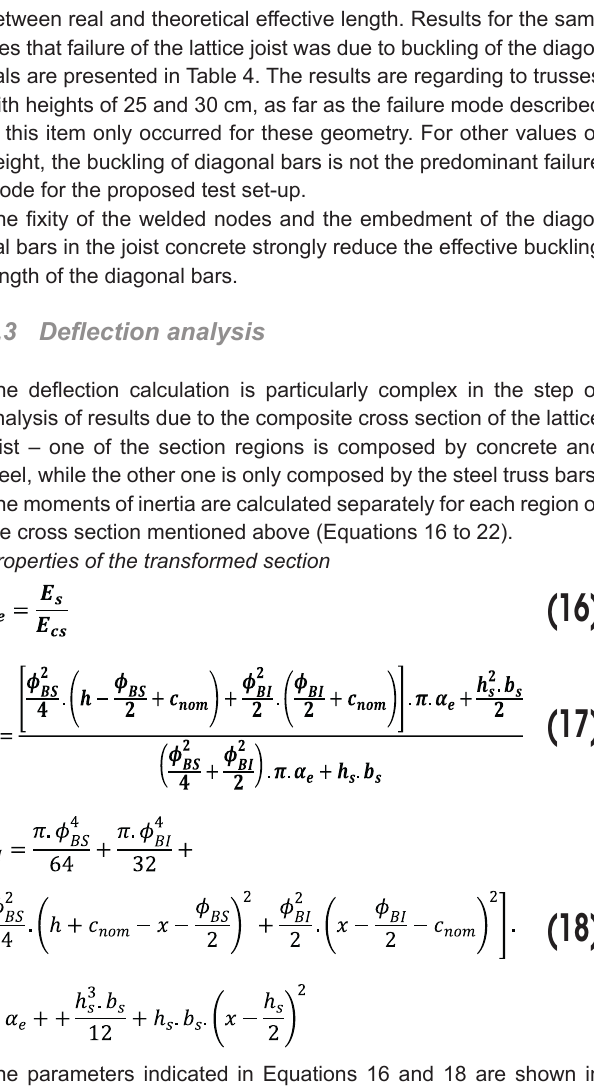
Joist cross section